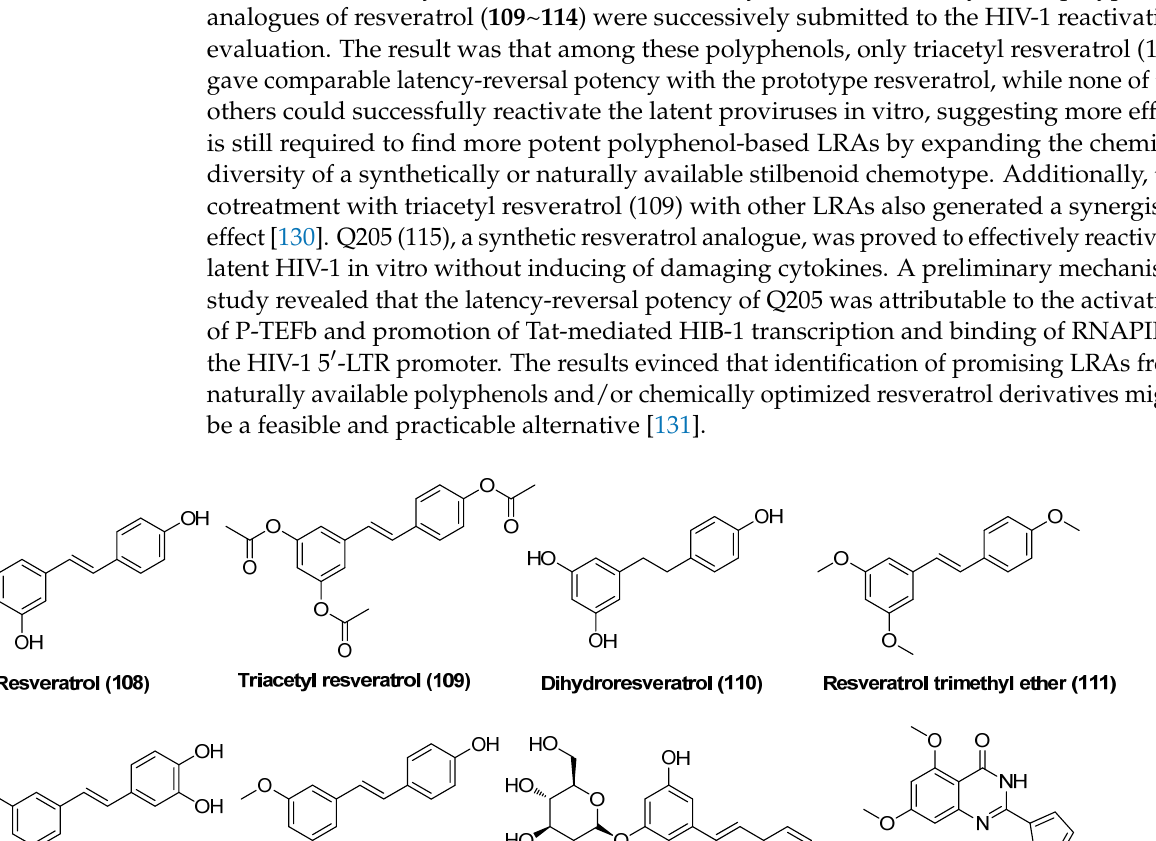
31 of 40 Figure 27. Chemical structure of niacinamide (107).